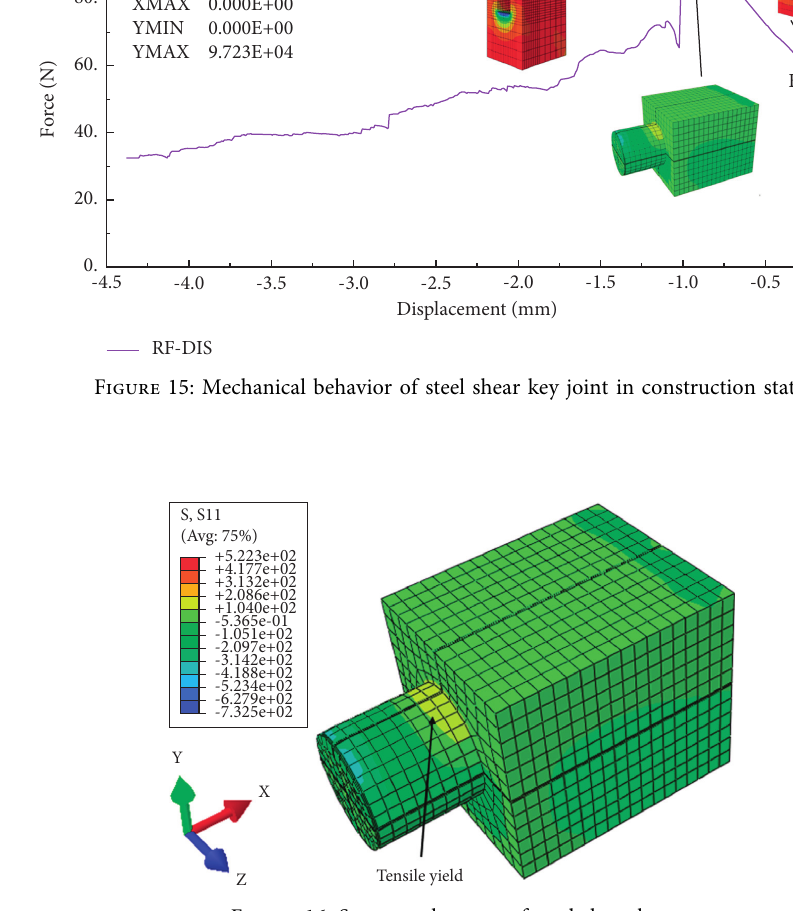
Figure 16: Stress nephogram of steel shear